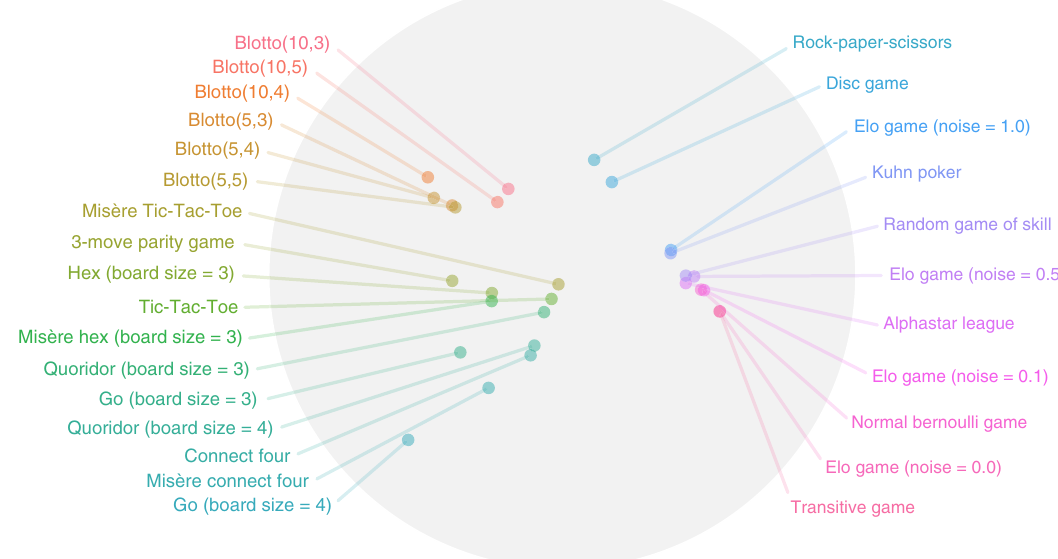
Fig. 1 A landscape of games revealed by the proposed response graph-based work fl ow. This landscape is generated by collecting features associated with the response graph of each game, and plotting the top two principal components. At a high level, games whose response graphs are characteristically similar are situated close to one another in this landscape. Notably, variations of games with related rules are well-clustered together, indicating strong similarity despite their widely-varying raw sizes. Instances of Blotto cluster together, despite their payoff table sizes ranging from 20 × 20 for Blotto(5,3) to 1000 × 1000 for Blotto(10,5). Games with strong transitive components (e.g., variations of Elo games, AlphaStar League, Random Game of Skill, and Normal Bernoulli Game) can be observed to be well separated from strongly cyclical games (Rock – Paper – Scissors and the Disc game). Closely-related real- world games (i.e., games often played by humans in the real world, such as Hex, Tic-Tac-Toe, Connect Four and each of their respective Misere counterparts) are also clustered